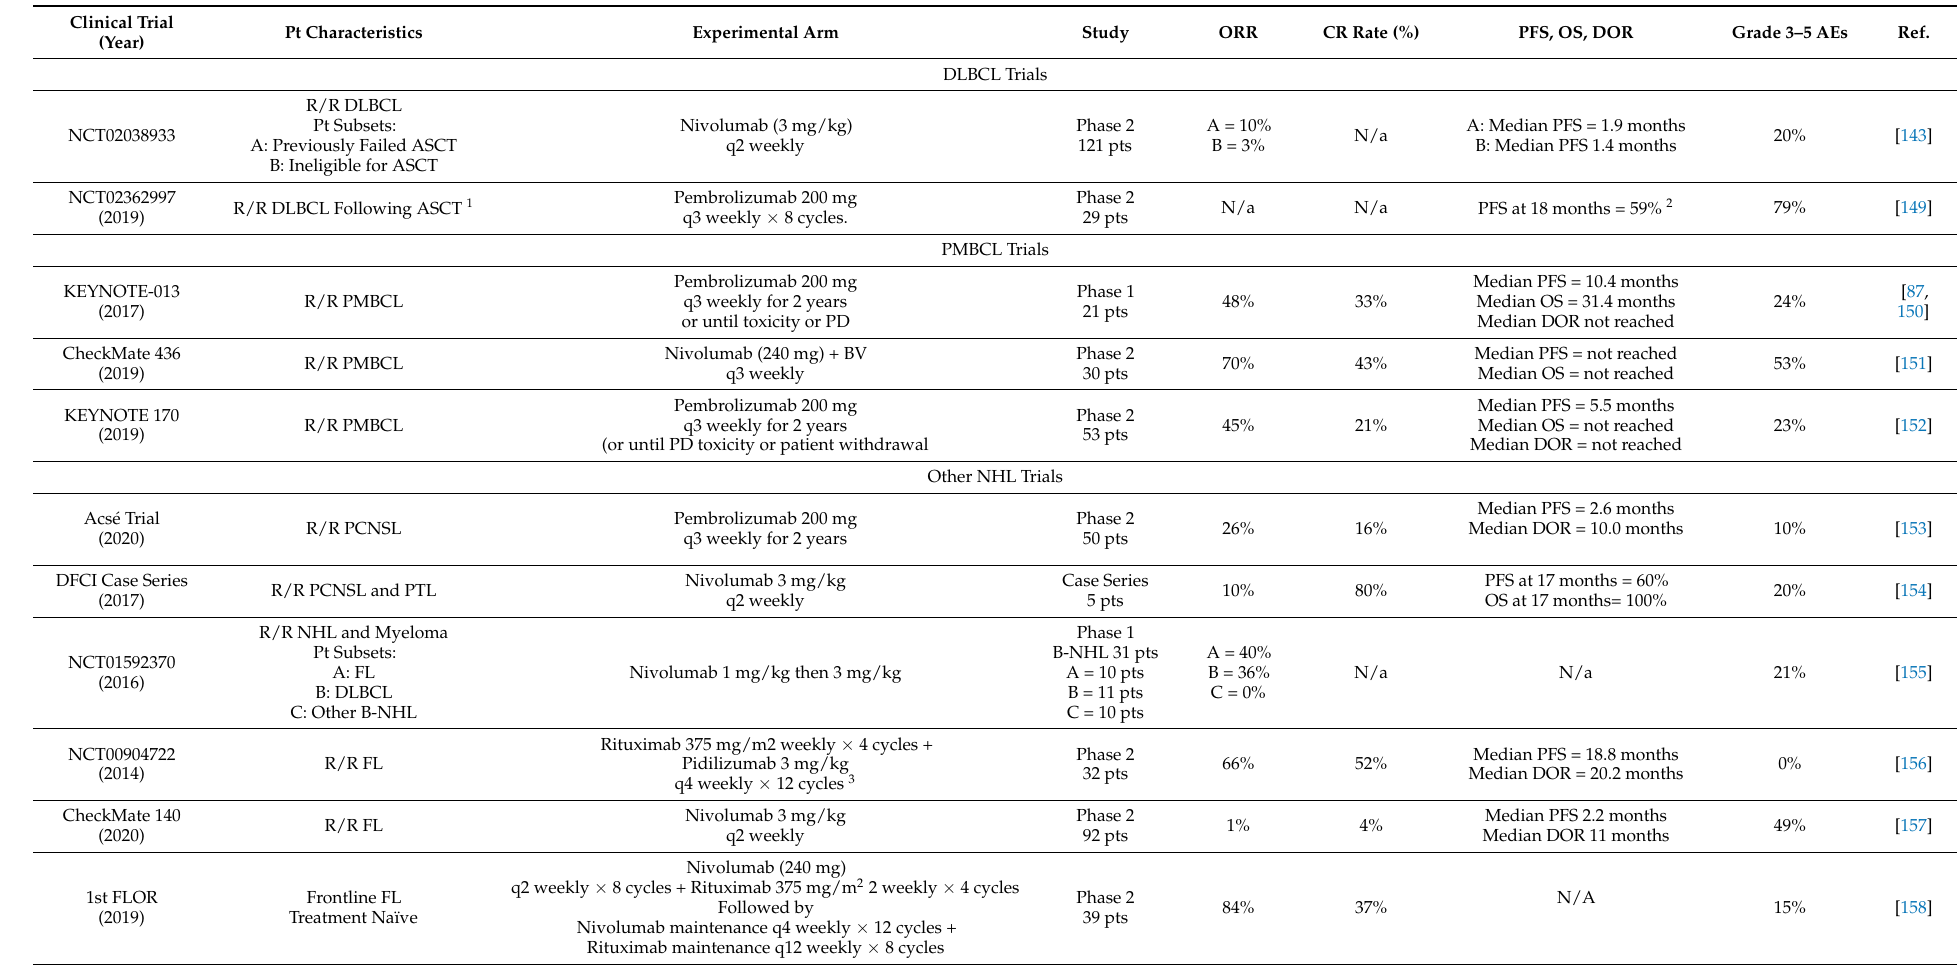
Table 2. Pivotal Trials in the Use of Immune Checkpoint Blockade in Non Hodgkin